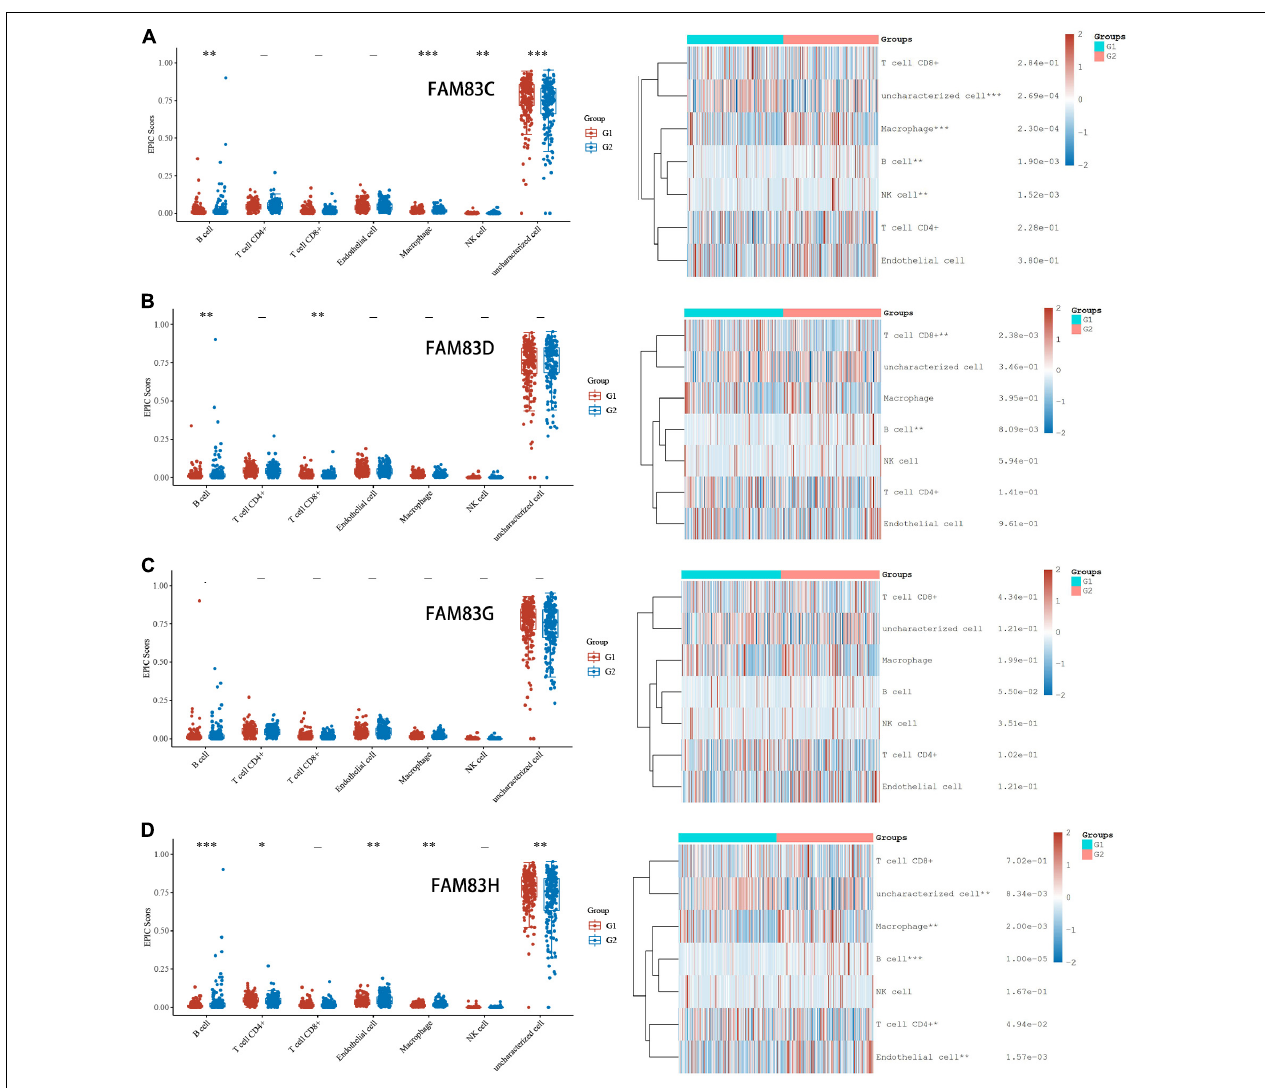
FIGURE 11 | (A–D) Immune Cell Infiltration of FAM83 FAM83C/D/G/H in STAD (TCGA). The box diagram on the left represented the score distribution of FAM83C/D/G/H in STAD tissues and normal tissues, where the horizontal axis represents different groups of samples, the vertical axis represents the gene expression distribution, where different colors represent different groups, and the upper left corner represents the significance p -value test method. The diagram on the left were immune cell score heat map, where different colors represent the expression trend in different samples, and the significance of two groups of samples passed the Wilcox test. Asterisks represent levels of significance. The asterisk represents the degree of importance (* p < 0.05, ** p < 0.01, *** p <